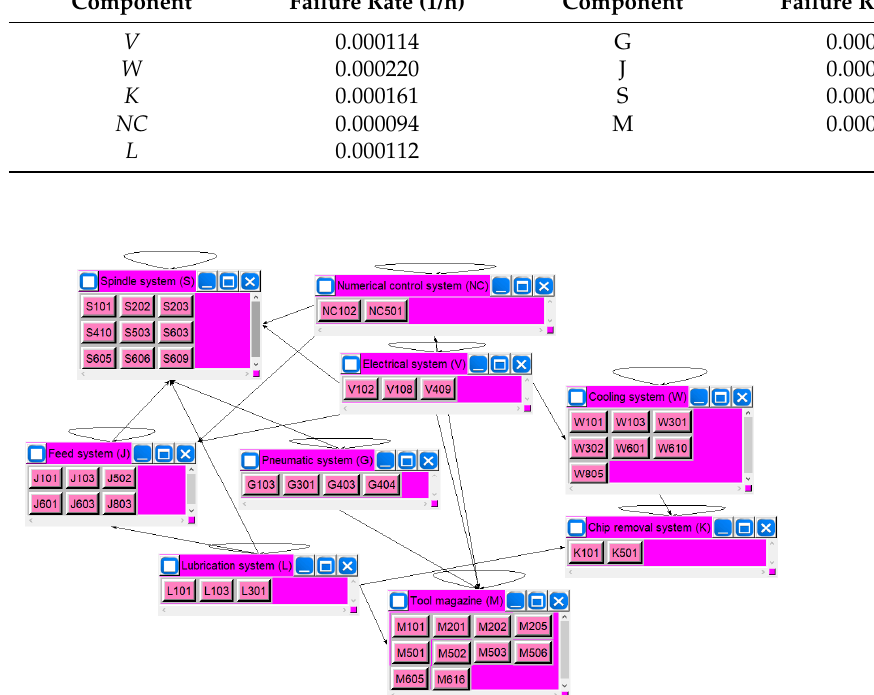
Figure 7. ANP model of failure mode of machining center.